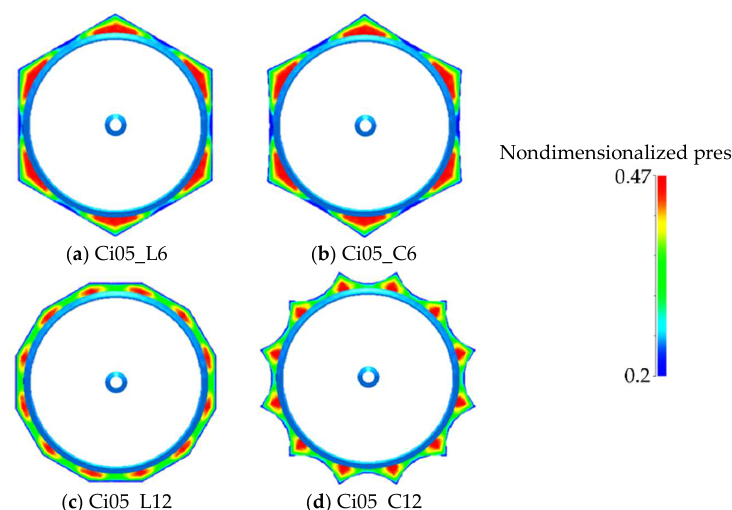
Figure 18. Time-averaged pressure distributions on the polygonal WLT brims: ( a ) Ci05_L6 (hexagon brim with straight sides, h = 0.05 D throat ); ( b ) Ci05_C6 (hexagon brim with curved sides, h = 0.05 D throat ); ( c ) Ci05_L12 (dodecagon brim with straight sides, h = 0.05 D throat ); ( d ) Ci05_C12 (dodecagon brim with curved sides, h = 0.05 D throat ).